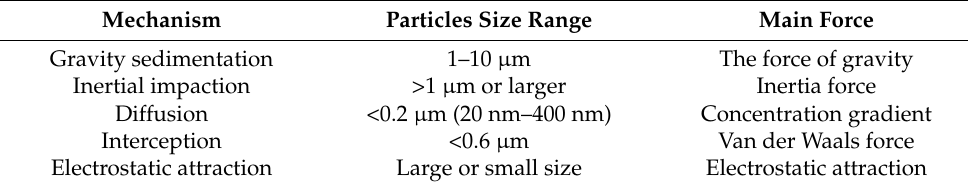
Table 1. Aerosol mechanism type, size, and driving